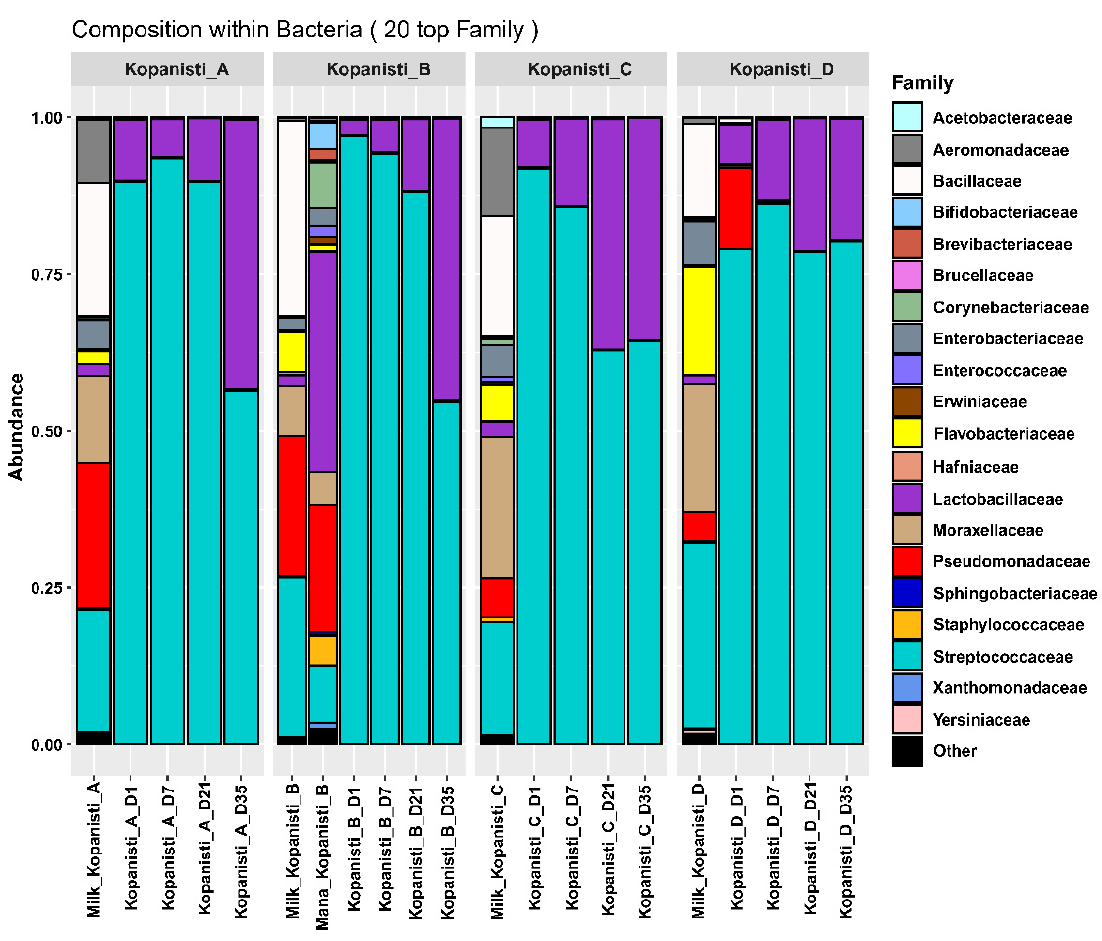
Figure 2. Composition plots of the relative abundances of the 20 most abundant bacteria zOTUs taxonomically assigned at the family level in pasteurized milk, Mana Kopanisti and Kopanisti cheese samples. Samples from each Kopanisti type (A–D) are presented together in subpanels.